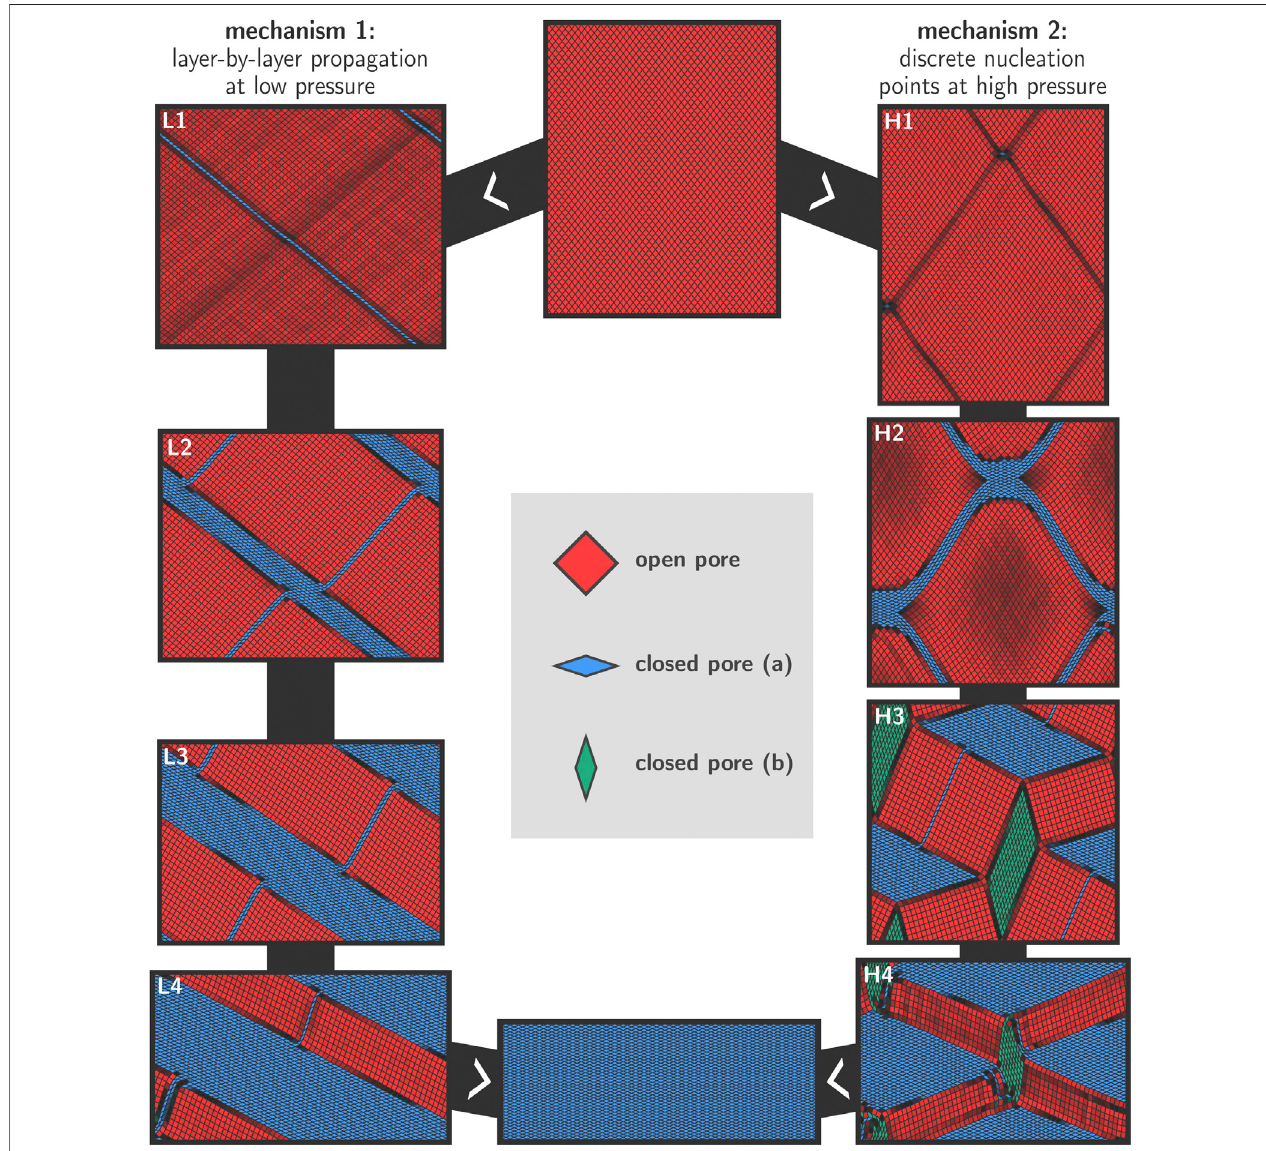
FIGURE 4 | Visualization of the two observed transition mechanisms for the lp – cp transformation in MIL-53(Al), as explained in Section 2.2. For lower pressures, a layer-by-layer mechanism is preferred in which the rhombus shape of the pores is approximately preserved throughout the transition (left) . For higher pressures, we observe discrete nucleation points and the formation of cp and lp domains (right)